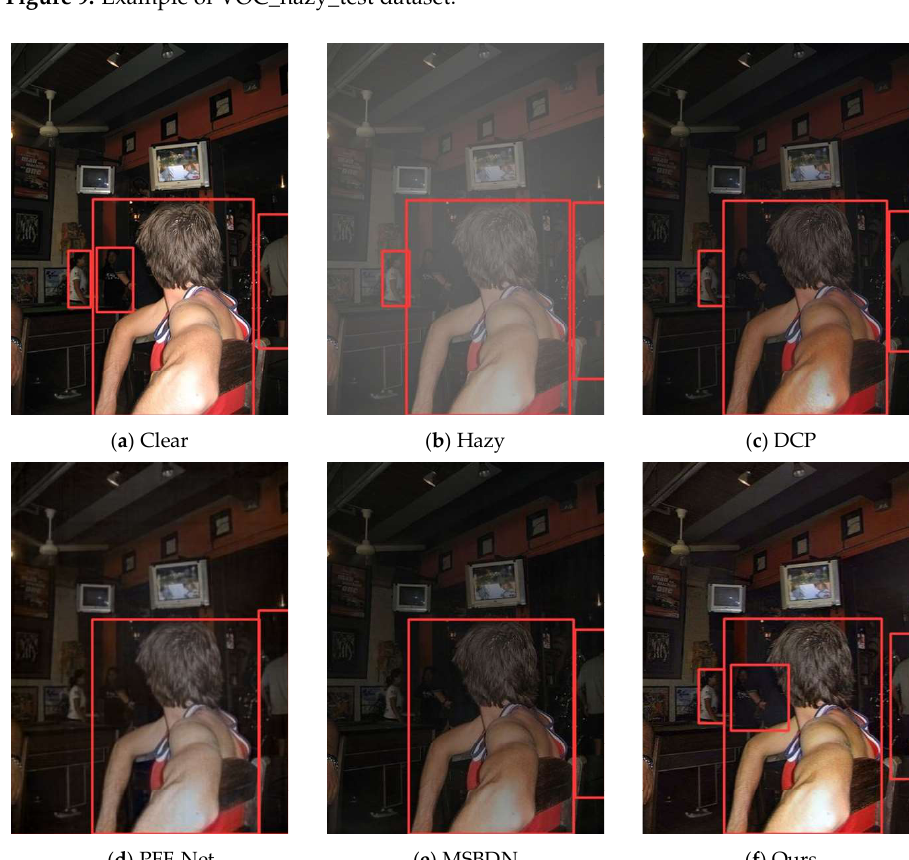
Table 2. Detection results on recovered images.